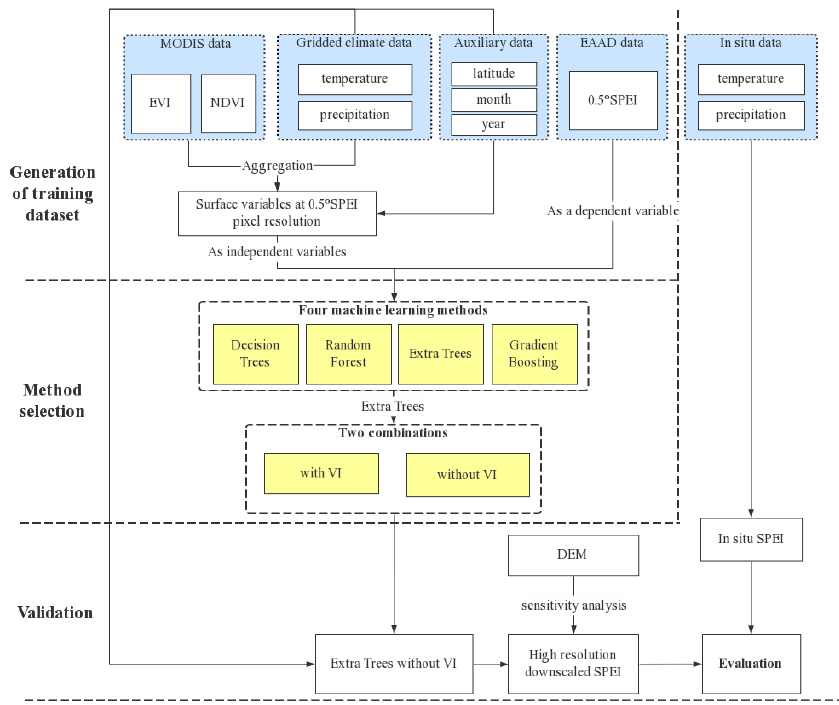
Figure 2. Flowchart of the downscaling procedure in this